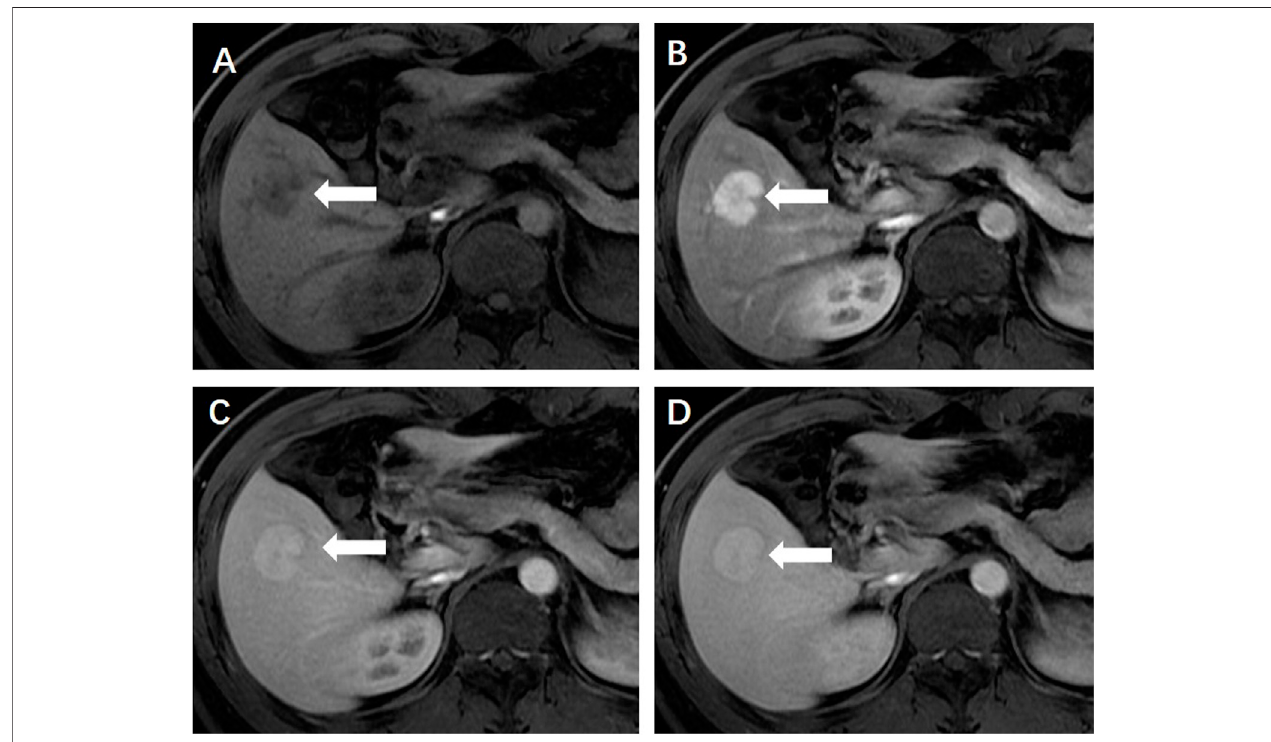
FIGURE 1 | (A) Enhanced magnetic resonance imaging revealed a solid focal liver lesion ( ← ) which showed hyperenhancement in the arterial phase (B) and isointensity in the portal venous (C) and delayed phase (D) .